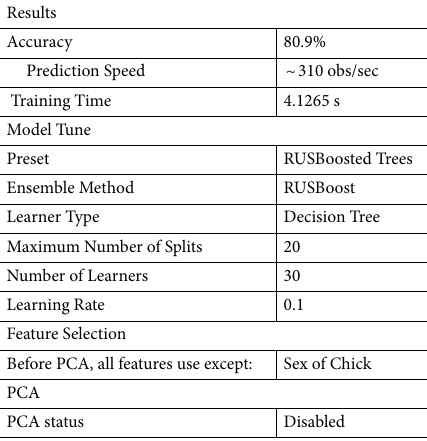
Table 1. The results and information of the RUSBoosted-tree model on